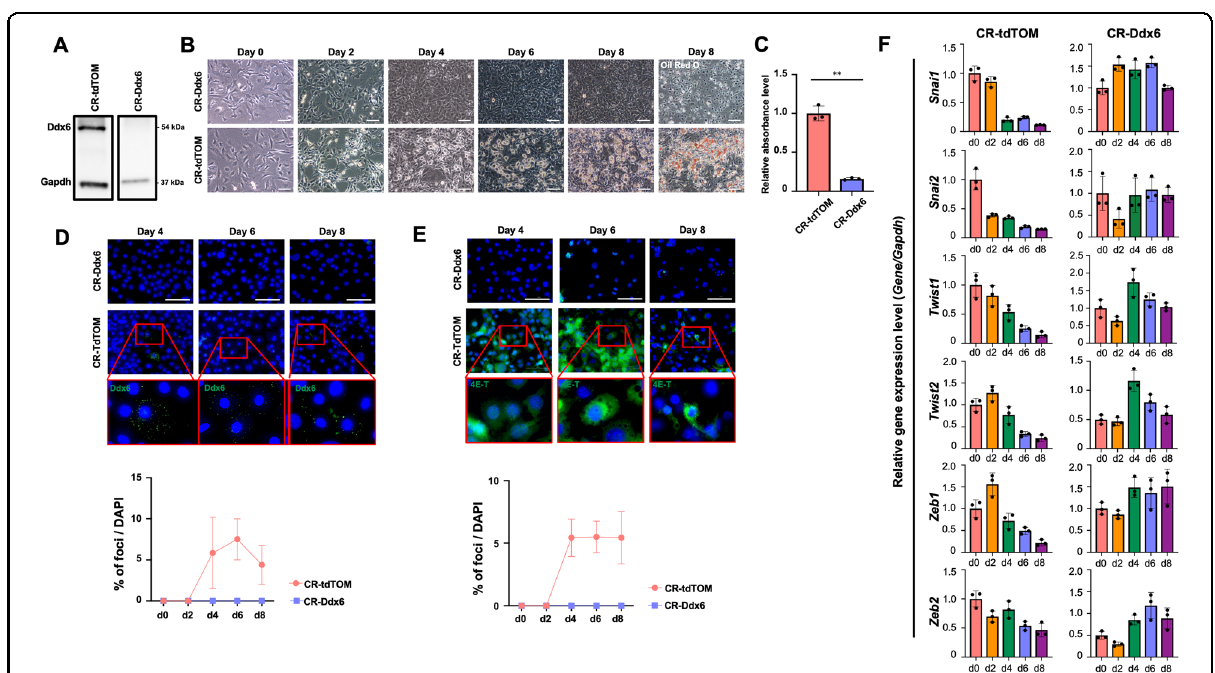
Fig. 2 Adipogenic differentiation of 3T3L1 Ddx6-KO preadipocytes. A Western blotting of 3T3L1 Ddx6-KO preadipocytes. B Phase-contrast microscopic images during adipogenesis. On day 8, cells were fi xed and stained with oil red O. The scale bar is 100 μ m. C Relative absorbance of oil red O. The error bars indicate the SDs ( n = 3). Double asterisks (**) indicate signi fi cance ( P < 0.01). D Immunocytochemistry of Ddx6 foci and the proportion of cells with foci during adipogenesis. The scale bar is 50 μ m. The error bars indicate the SDs ( n = 6). E Immunocytochemistry of 4E-T foci and the proportion of cells with foci during adipogenesis. The scale bar is 50 μ m. The error bars indicate the SDs ( n = 6). F RT-qPCR analysis of gene expression during adipogenesis. Individual RNA expression levels were normalized to Gapdh expression levels. The error bars indicate the SDs ( n =